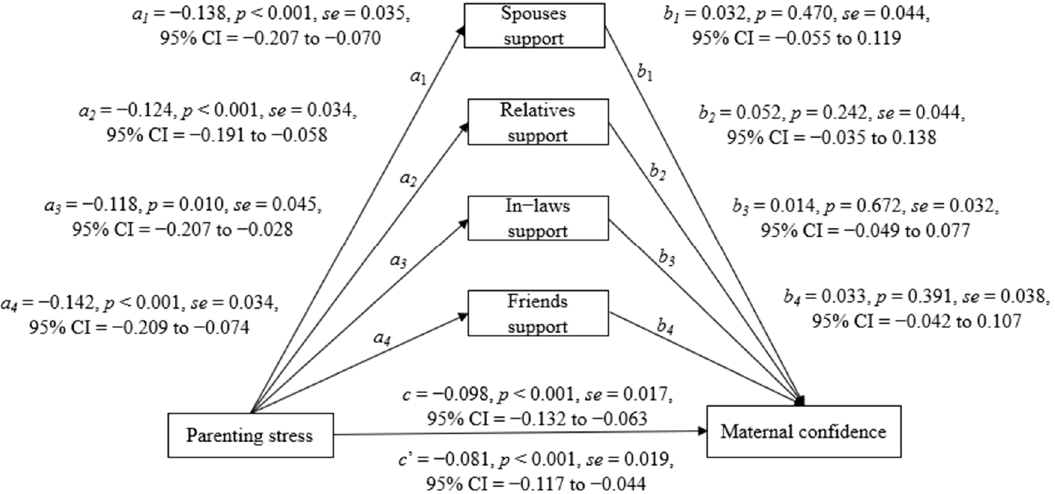
Figure 2. Effects of parenting stress on maternal confidence with the mediator of sources of social support, adjusted for infant age by month ( N = 205).